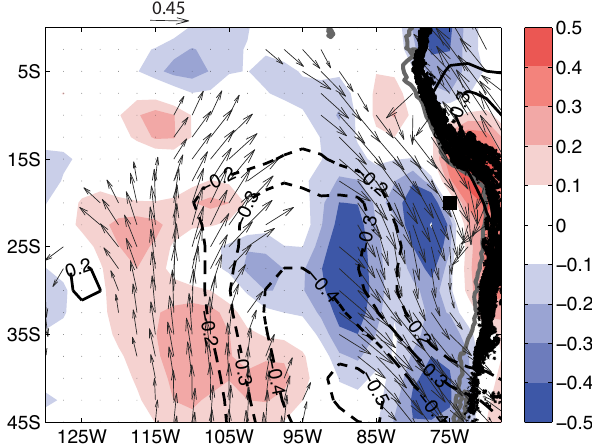
Fig. 10. One point correlation between the potential temperature at 20 ◦ S and 75 ◦ W (square) and: subsidence (pressure velocity dp/dt, colors; positive values imply subsidence), geopotential height (contours) and wind (arrows), all at 850hPa. Absolute values of correlation higher than 0.25 for the geopotential height and subsi- dence fields pass the 99% significance level of a Student’s t test. The winds are only shown if the meridional component of the wind-temperature correlation is statistically significant. Topogra- phy higher than 1500m is indicated by the black